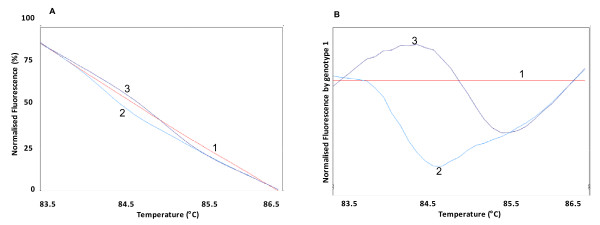
Genotyping of rs7412 through HRM analysis. A: Normalized fluorescence by temperature. B: Normalized fluorescence (based on genotype 1) by temperature. 1: wild-type genotype; 2: heterozygous genotype; 3: homozygous genotype for the APOE rs7412 polymorphism.